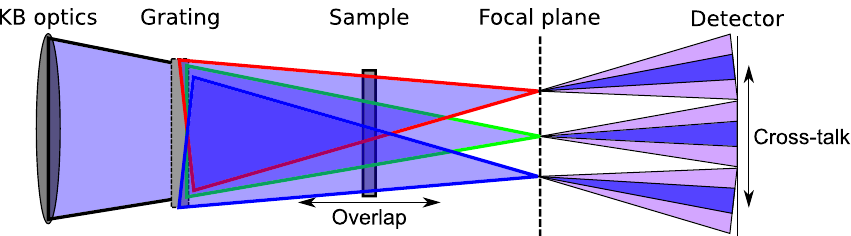
Figure 1. A schematic 2D diagram of the proposed experimental setup. The FEL beam is focused downstream of the sample by the pair of KB mirrors. The beam-splitting grating is placed in front of the sample and splits the beam into several diffraction orders (shown in red, green, and blue). The sample, placed in the vicinity of the grating, is illuminated by the overlapping beamlets produced by the grating. The degree of overlap and the field of view in the sample plane can be controlled by changing the grating-sample distance. The detector is placed downstream of the focal plane. The focal length of the KB mirrors is selected such that a separation of the beamlets is facilitated (dark blue) and possible cross-talk between the radiation scattered by the sample minimized